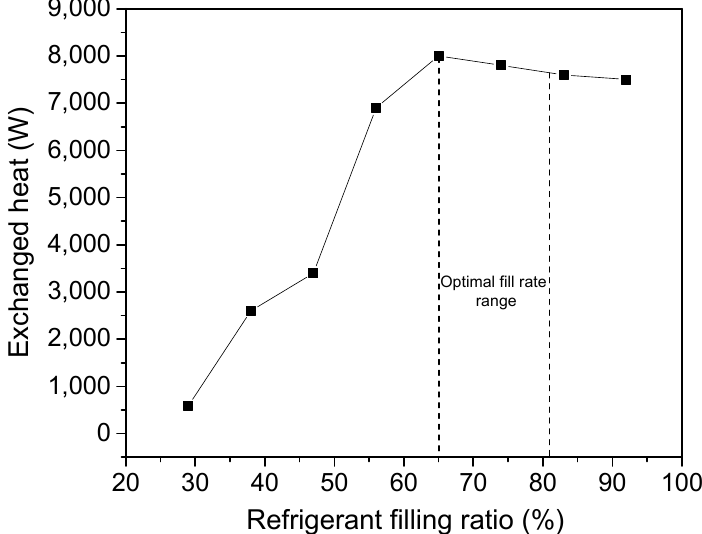
Figure 3. Change of heat exchange with refrigerant filling rate.